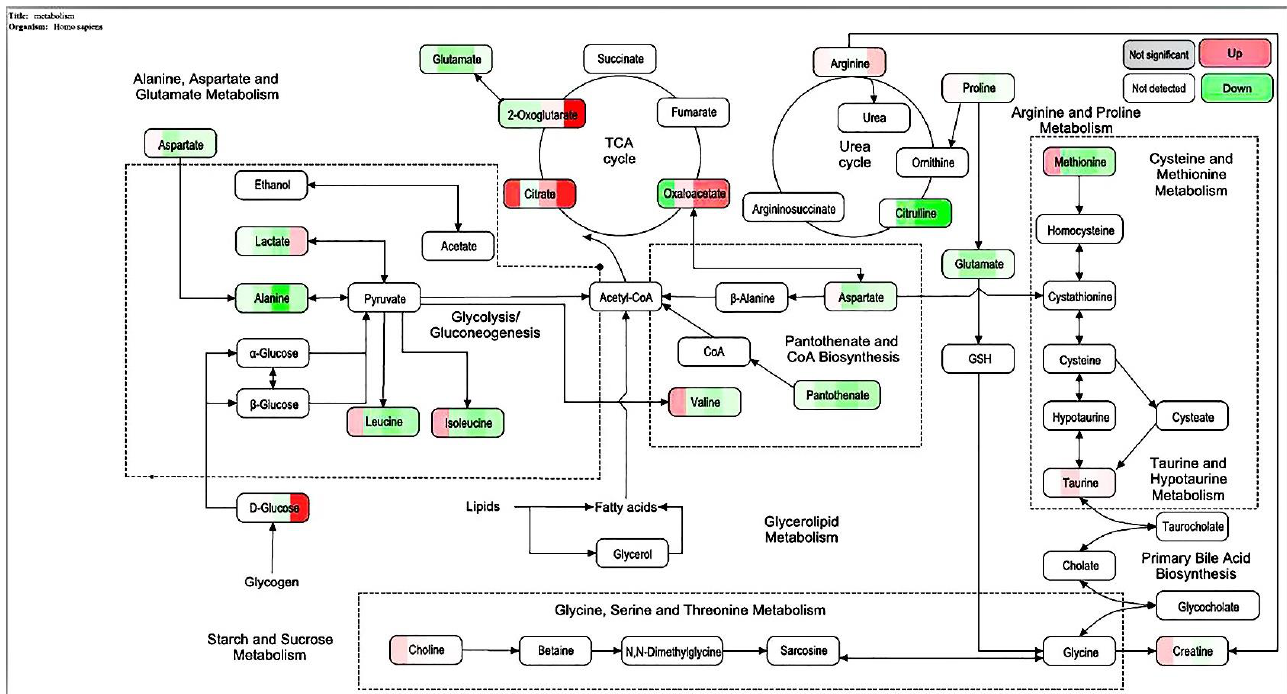
Figure 10. Bubble diagram of the importance of the metabolic pathway of L-02 cells and the roles of active peptides from Camellia vietnamensis meal and ethanol.